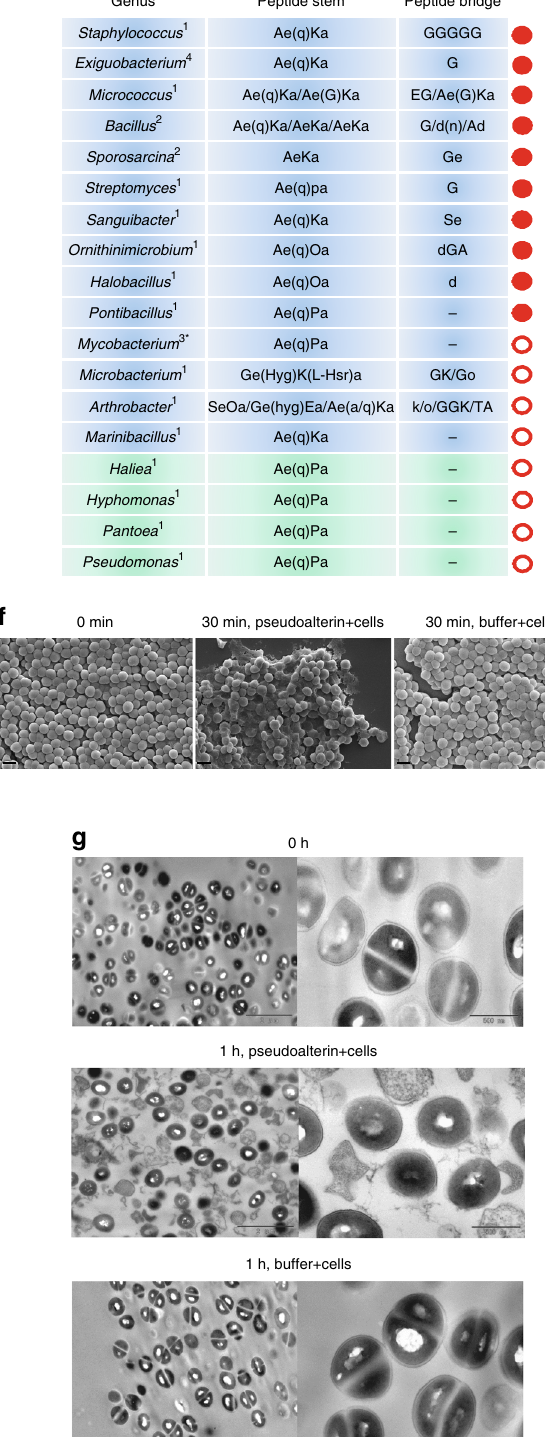
2 mM glycine in the medium induced the secretion of active pseudoalterin and the further addition of glycine after 6 and 12 h could signi fi cantly increase the production of active pseudoalterin (Fig. 4e). This indicates that the induction of pseudoalterin synthesis in strain CF6-2 needed a constant stimulation by extracellular glycine in appropriate concentrations. Glycine exists in the peptide bridges of PG of a variety of Gram-positive bacteria but absent from PG from Gram-negative bacteria and certain